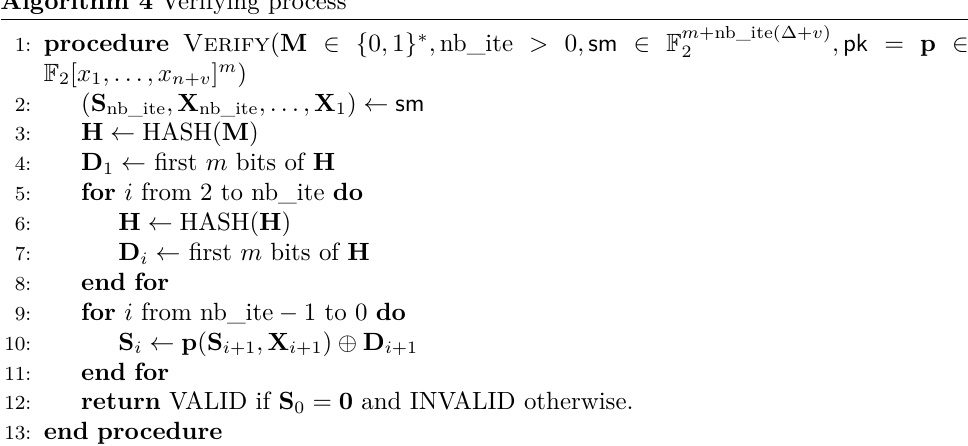
Algorithm 4 Verifying